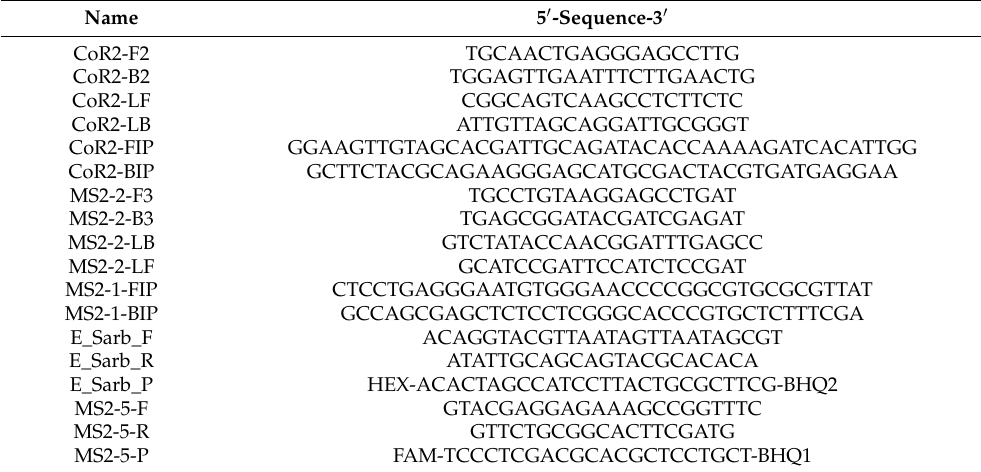
Table 2. List of oligonucleotide primers and probes